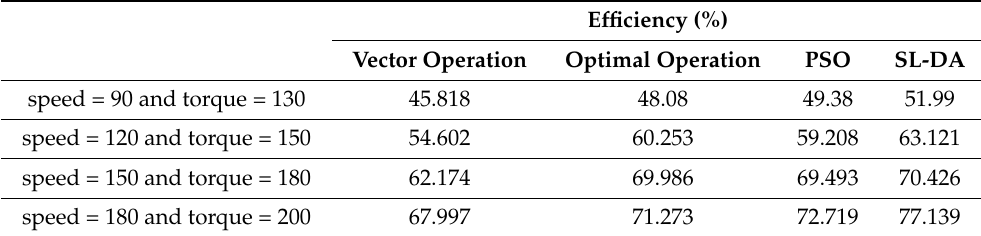
Table 2. Efficiency analysis of proposed work over state-of-the-art models.